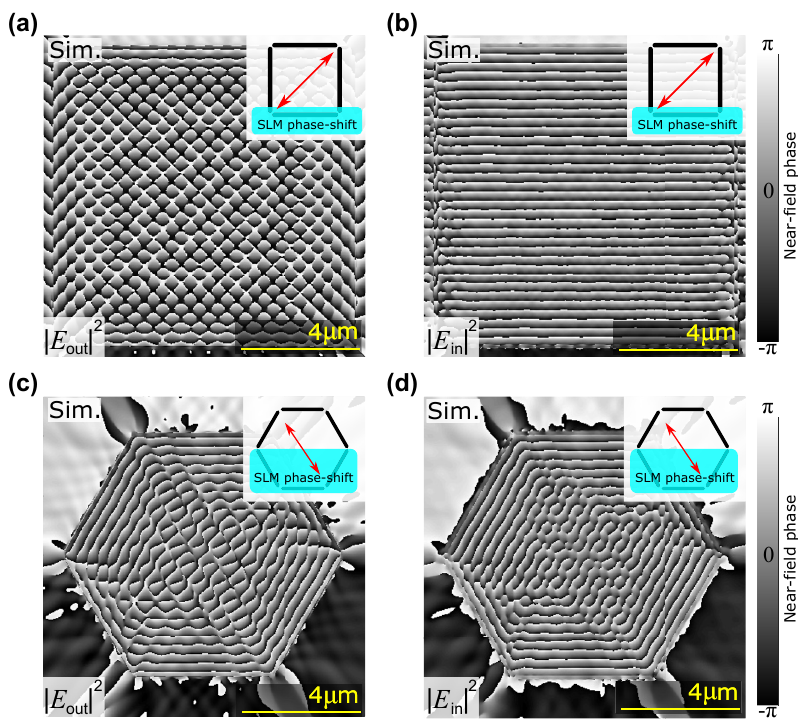
Figure 7: Numerical calculations for individ- ual components of near-field phase distri- bution on square SPID. Phase distribution of the two components of the electric field (out-of-plane and in-plane) reconstructed from FDTD simulations for two SPIDs (square andhexagonal).(a) and(b) Square SPID,out- of-plane (a) and in-plane (b) components. (c) and (d) Hexagonal SPID, out-of-plane (c) and in-plane (d) components. Insets represent square and hexagonal arrangements of slits withtheturquoisepatchrepresentingtheREF wave area and the red double-sided arrow representing the illumination